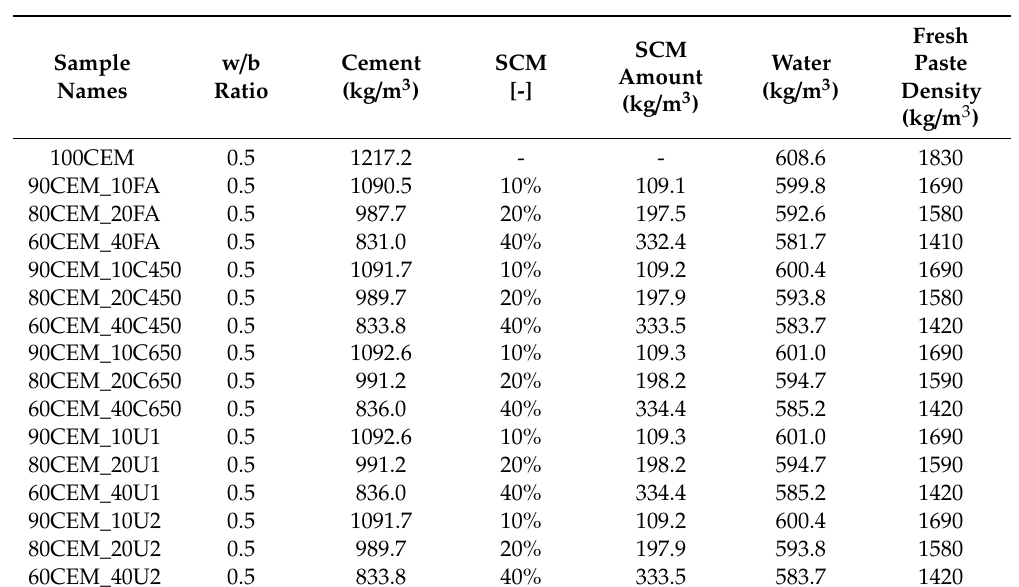
Table 4. Cement paste